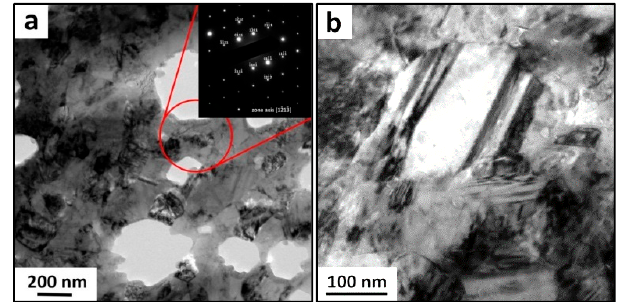
Figure 2. TEM micrographs of bulk ultrafine-grained cobalt. ( a ) an overview micrograph with SAED pattern taken from marked area; ( b ) a detailed view of single grain.